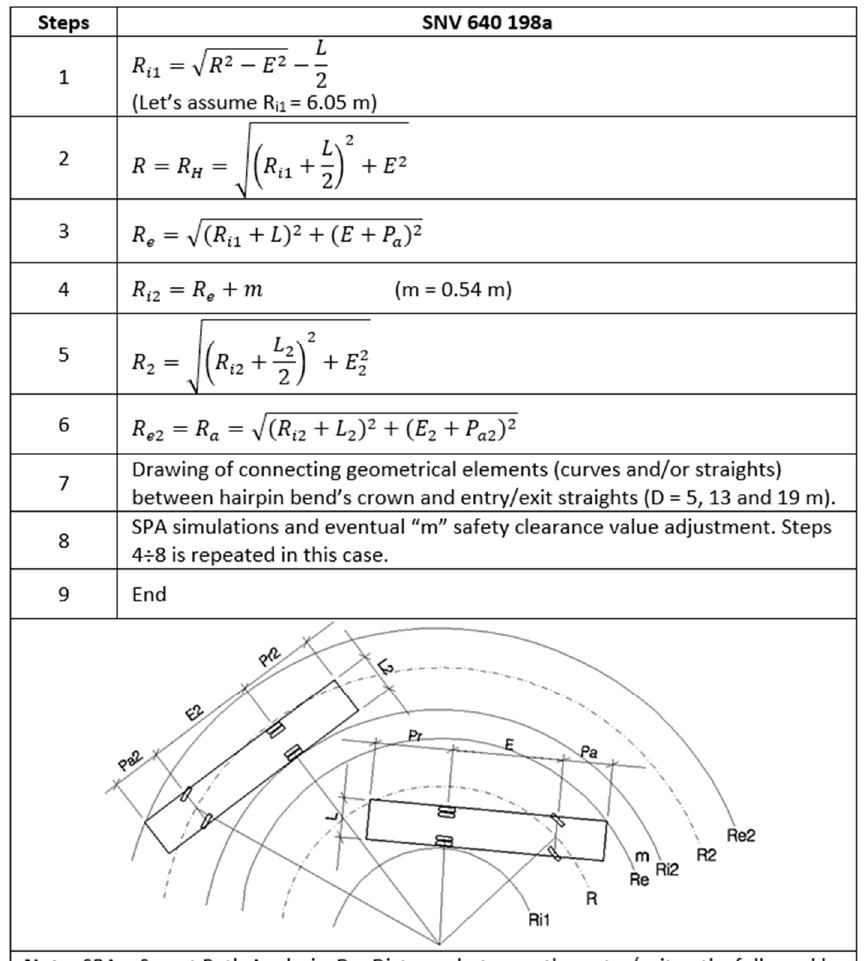
Figure 2. Bend insertion of two two ‐ axle vehicles: SNV 640198a.